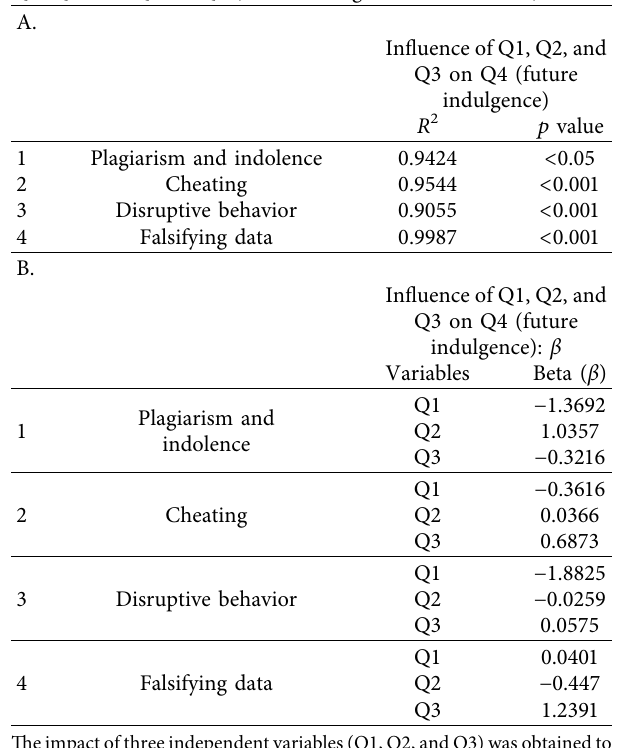
Table 3: Multiple linear regression analyses to assess the effect of Q1, Q2, and Q3 on Q4 (future indulgence in a